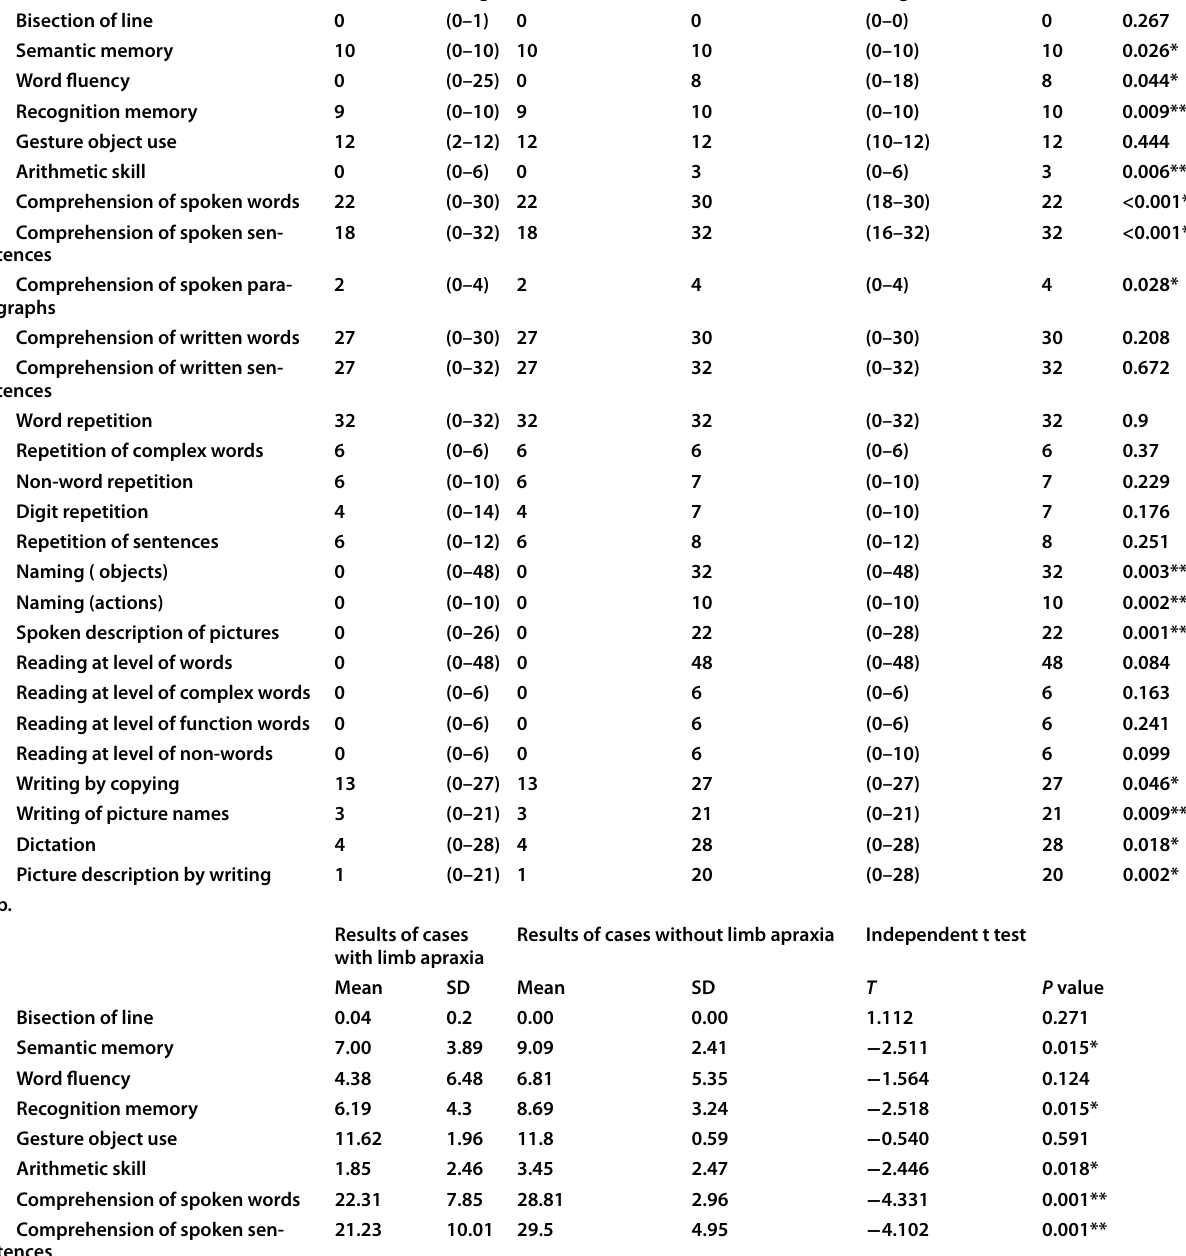
Table 4 Comparison between patients with limb apraxia and without limb apraxia regarding scores of aphasia test. Table 4 (a) that was statistically analyzed using the median shows that there was a significant difference between patients with limb apraxia and patients without limb apraxia in the scores of aphasia test in word fluency, semantic and recognition memories, arithmetic, spoken word, sentences and paragraph comprehension, naming tasks, spoken picture description, and writing tasks. Table 4 (b) that was statistically analyzed using the mean reveals that there was a significant difference between patients with limb apraxia and patients without limb apraxia in the scores of aphasia test in semantic and recognition memories, arithmetic, spoken word, sentence